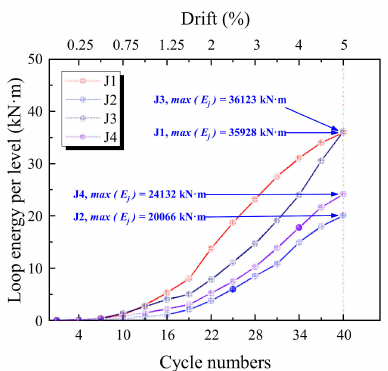
Figure 17. Loop energy per level.